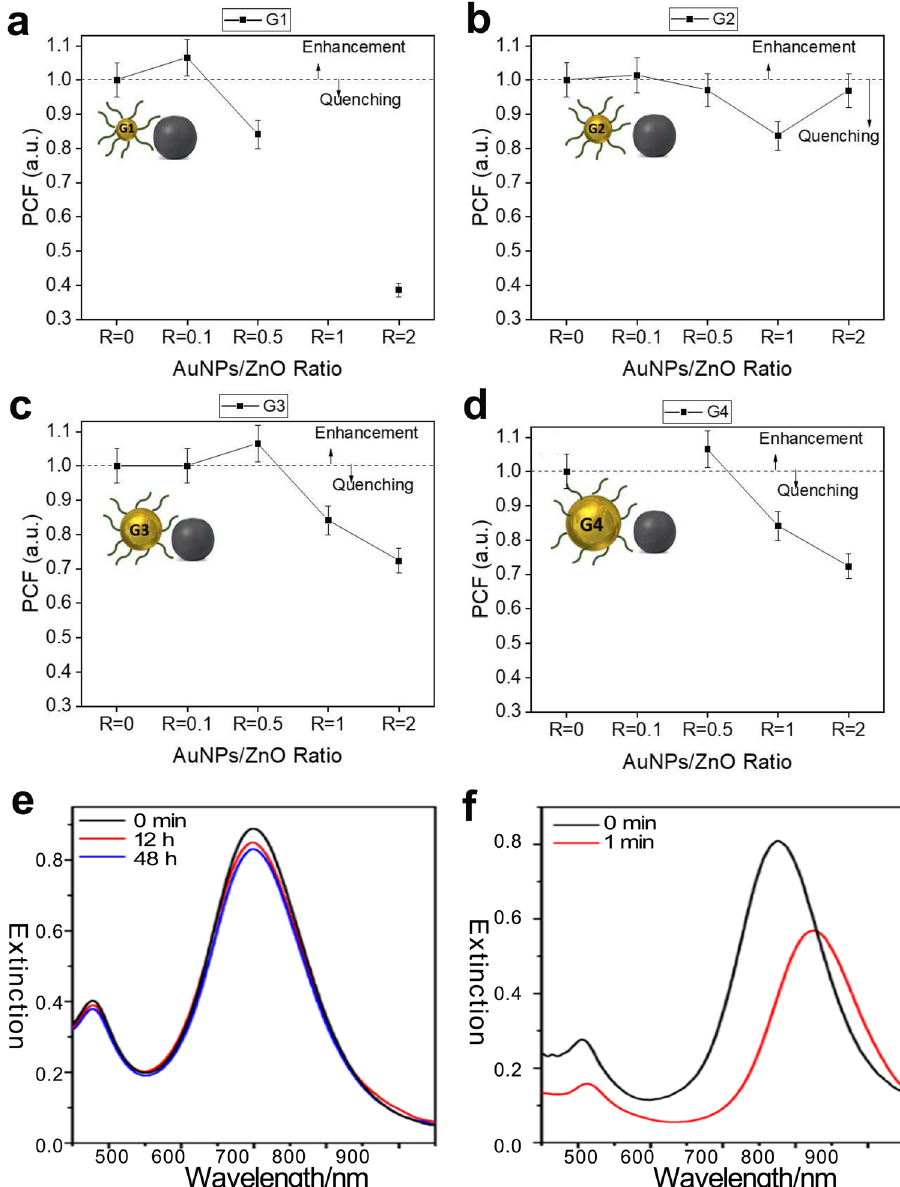
Figure 9: ( a – d ) Photocatalysis modi fi cation factor of hybrid samples, before ( R = 0 ) and after the addition of various - size CTAB - capped Au NPs in di ff erent volumes into ZnONPs dispersions using ( a ) G1, ( b ) G2, ( c ) G3, and ( d ) G4. Reproduced with permission [ 137 ] . Copyright 2020, Wiley. ( e and f ) UV - vis extinction spectra showing the stability of ( e ) fully alloyed AuAg NRs - 2.5 and ( f ) Au@Ag NRs - 2.5 in a mixing solution of NH 4 OH ( 0.5 M ) and H 2 O 2 ( 0.5 M ) . Reproduced with permission [ 148 ] . Copyright 2018, American Chemical